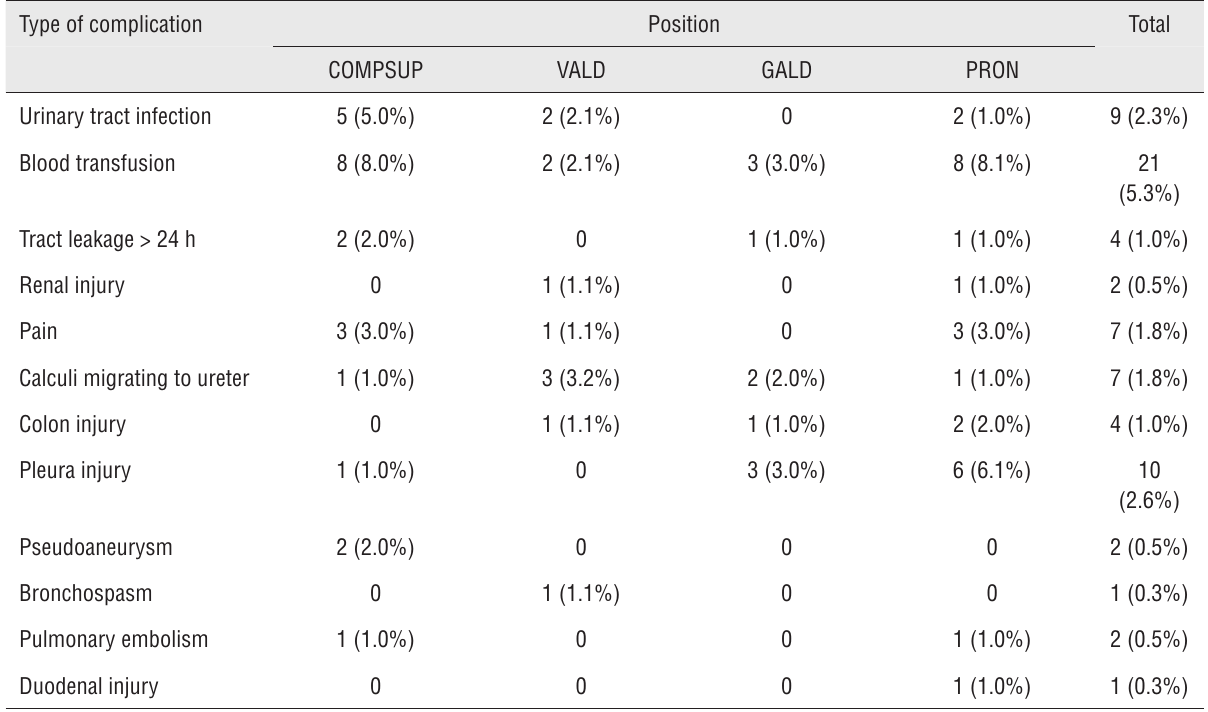
Table 4 - complications according to PcNL position.